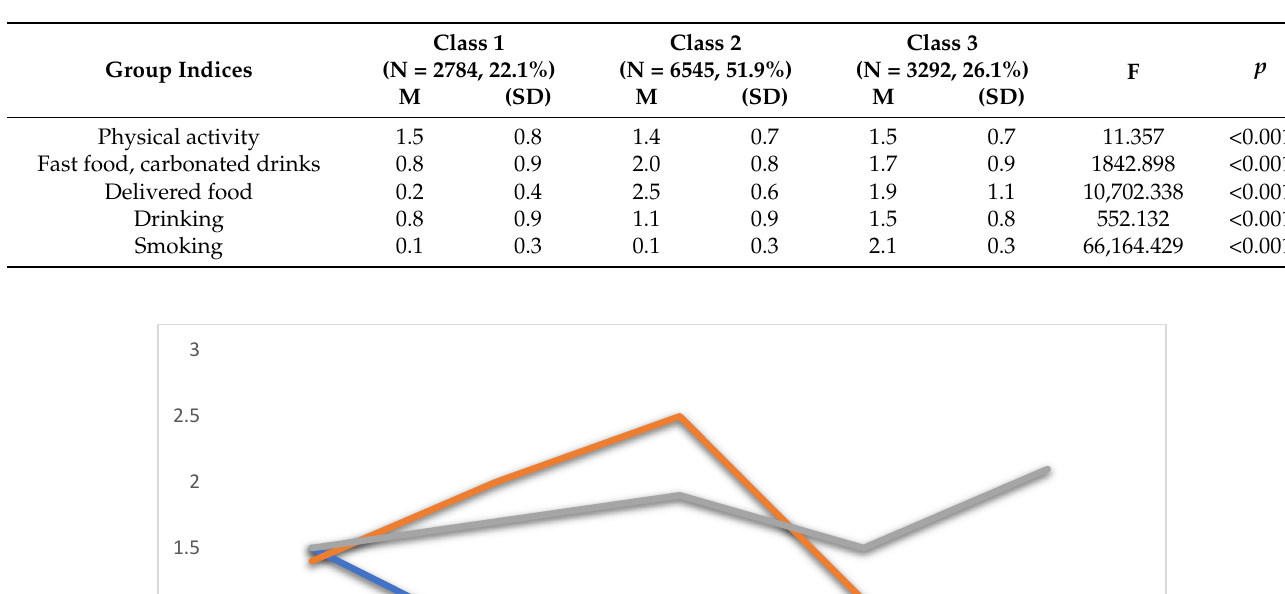
Table 4. Differences in latent classes for health behaviors due to COVID-19.